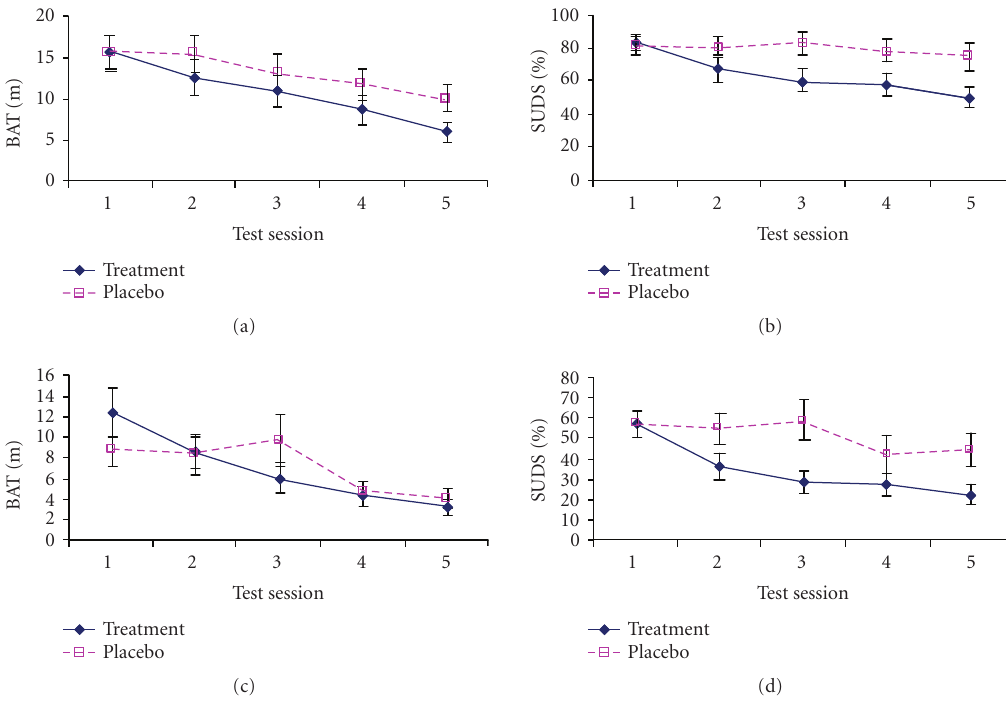
Figure 2: Time course of the BAT and SUDS means with a real spider, (a) and (b), and with a spider photo, (c) and (d), for placebo and treatment groups. Vertical segments indicate standard error.